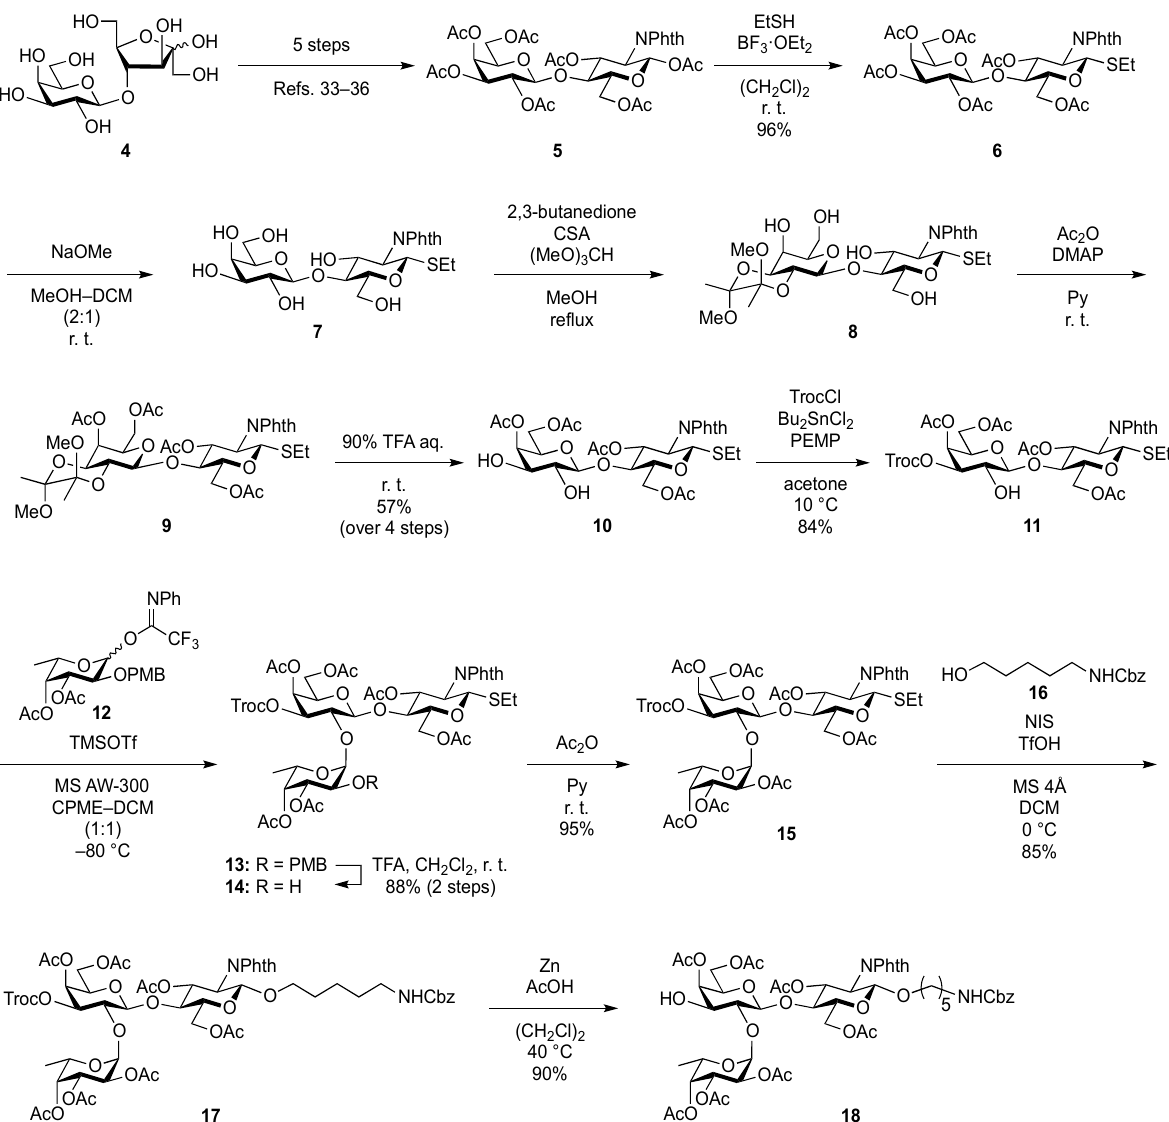
Scheme 2. Synthesis of the common trisaccharide